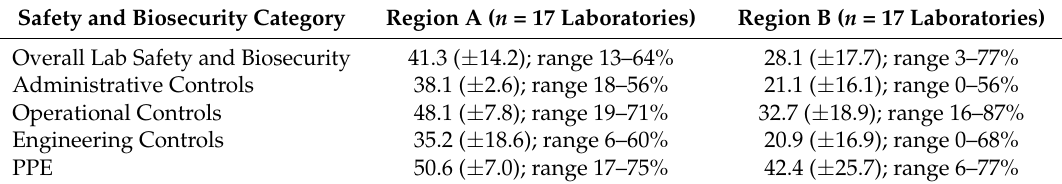
Table 3. Summary scores from initial